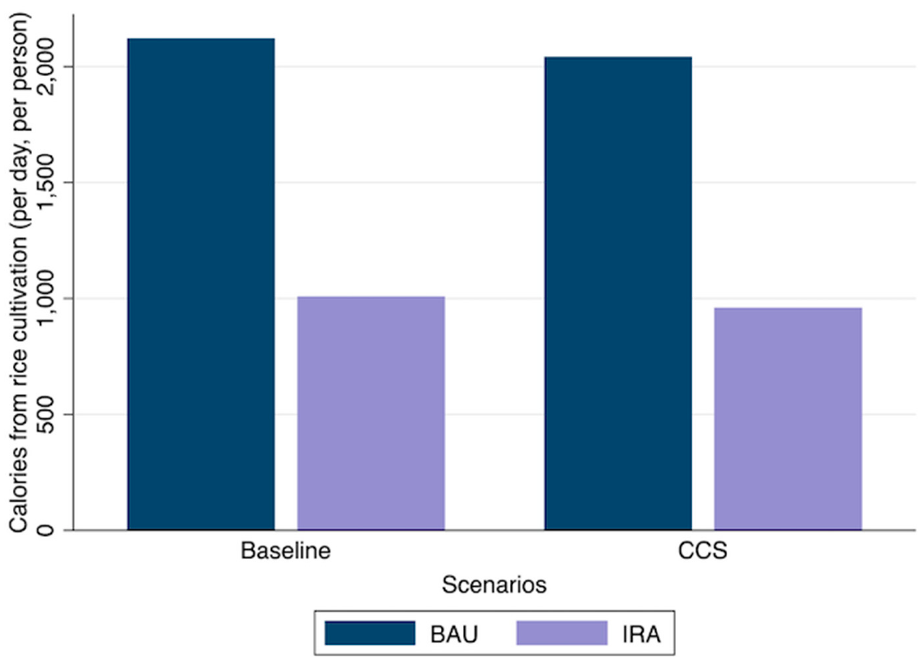
Figure A5. Simulation results: generated calories from rice cultivation in the baseline and climate change scenario.